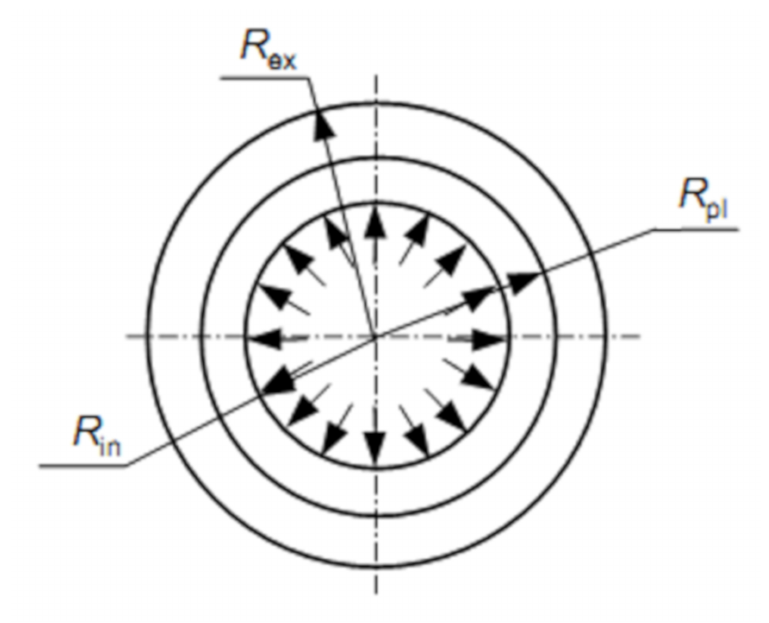
Figure 5. Cross-sectional view of tube